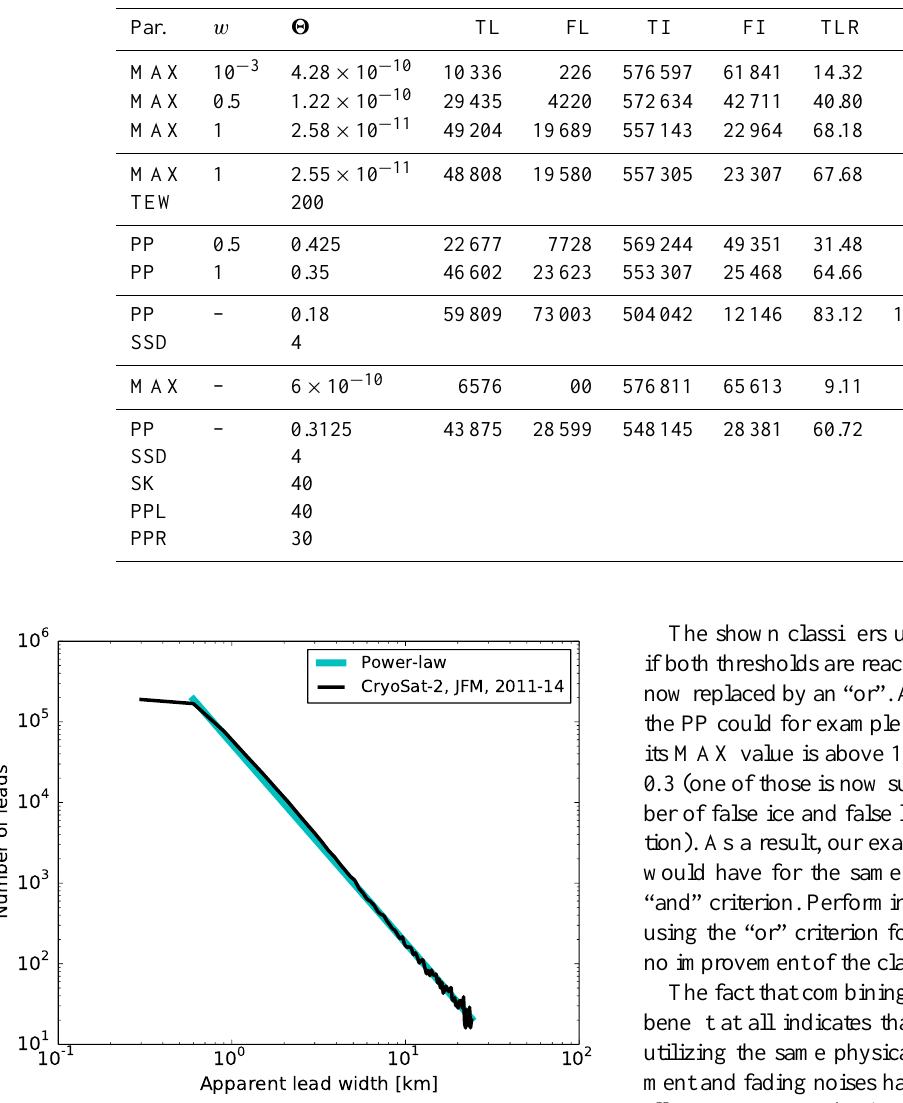
Figure 10. Apparent lead width distribution from all CS-2 SAR mode ocean measurements north of 65 ◦ N in winter season (JFM) from 2011 to 2014. The distribution of a power law with exponent of 2.47 is included for comparison, forming a straight line in a dou- ble logarithmic presentation. See text for definition of the apparent lead